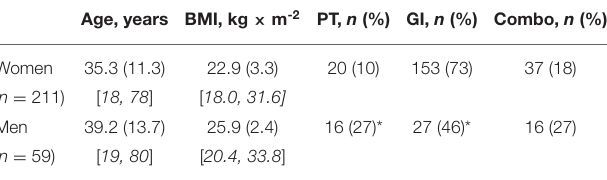
TABLE 1 | Demographic information on female and male fitness instructors included in this